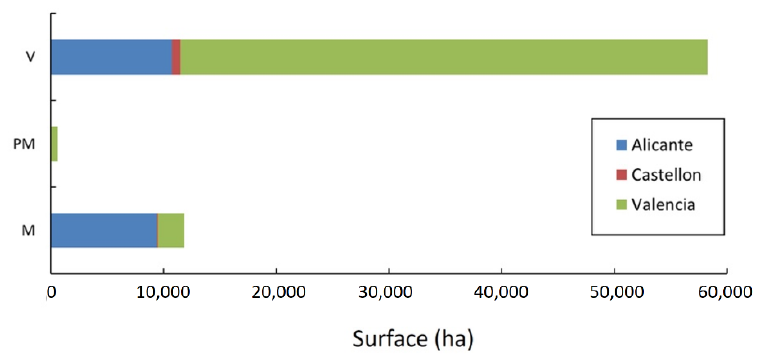
Figure 3. Type of wine cultivated (winemaking processes: ‘V’; table wine: ‘M’; mother vine: ‘PM’) in each province of the Valencian Community.